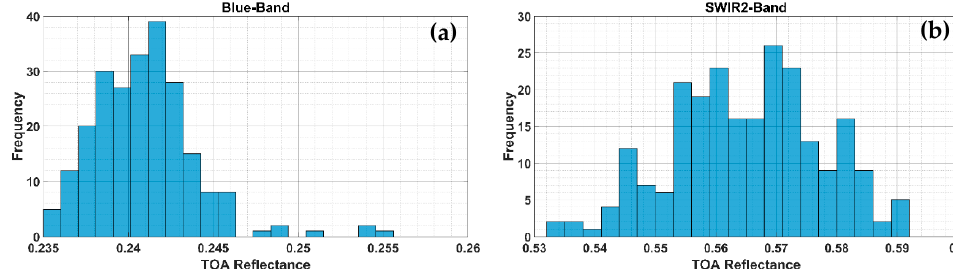
Figure 3. Histogram of ETM+ BRDF-corrected Mean TOA Reflectance of Libya 4; ( a ) Blue band; ( b ) SWIR2 band. Table 6. Shapiro-Wilk Normality Test of BRDF-corrected Mean TOA Reflectance of Libya 4 by Sensor, α = 0.05.